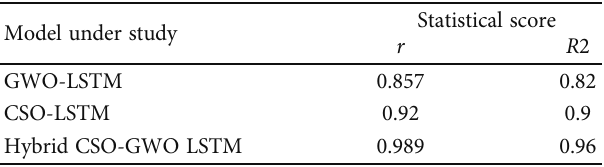
Table 2: Statistical analysis of the proposed